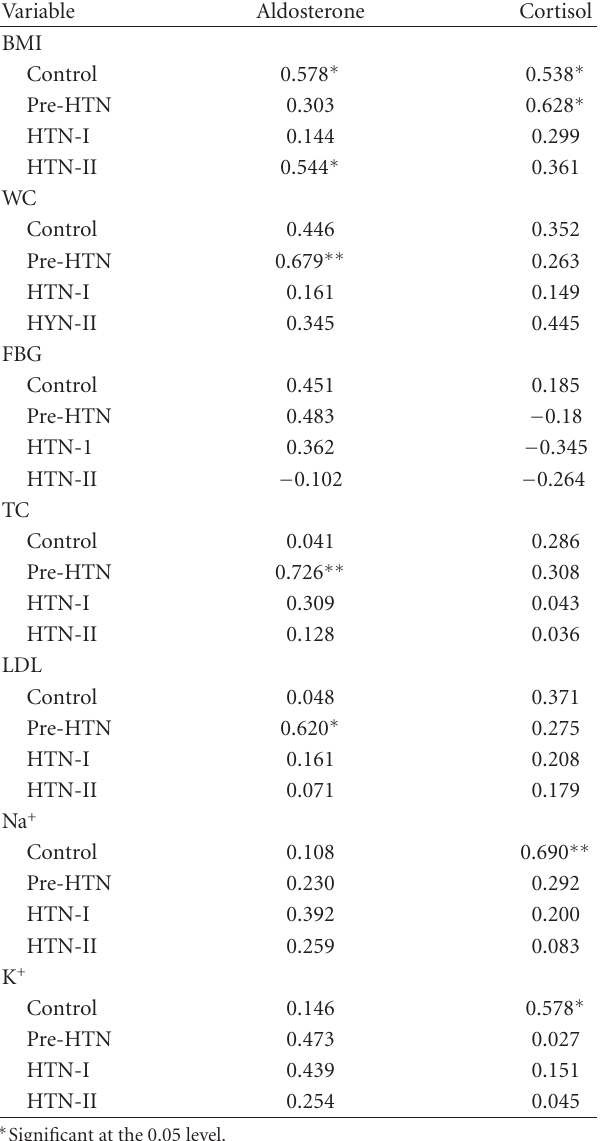
Table 2: Coe ffi cient correlation ( r ) to identify the association of di ff erent variables with one another among four groups.